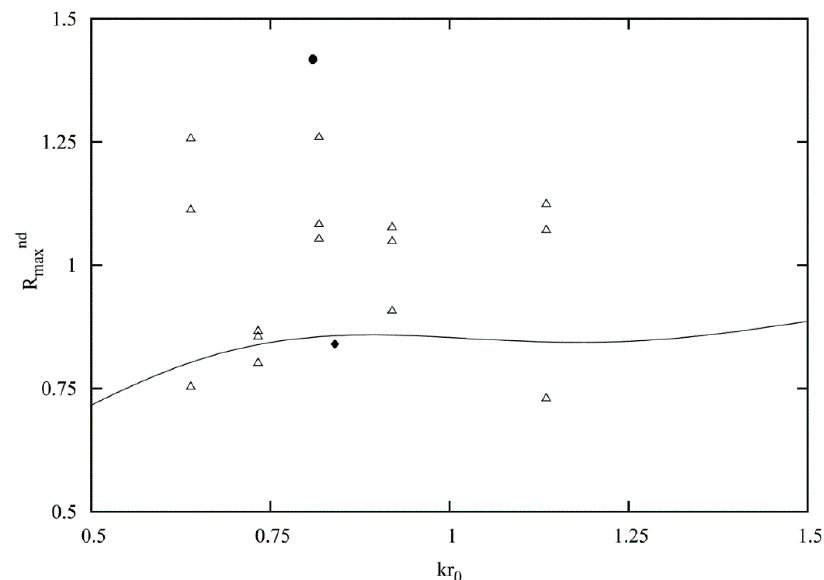
kr : (—) solution of MacCamy and 0